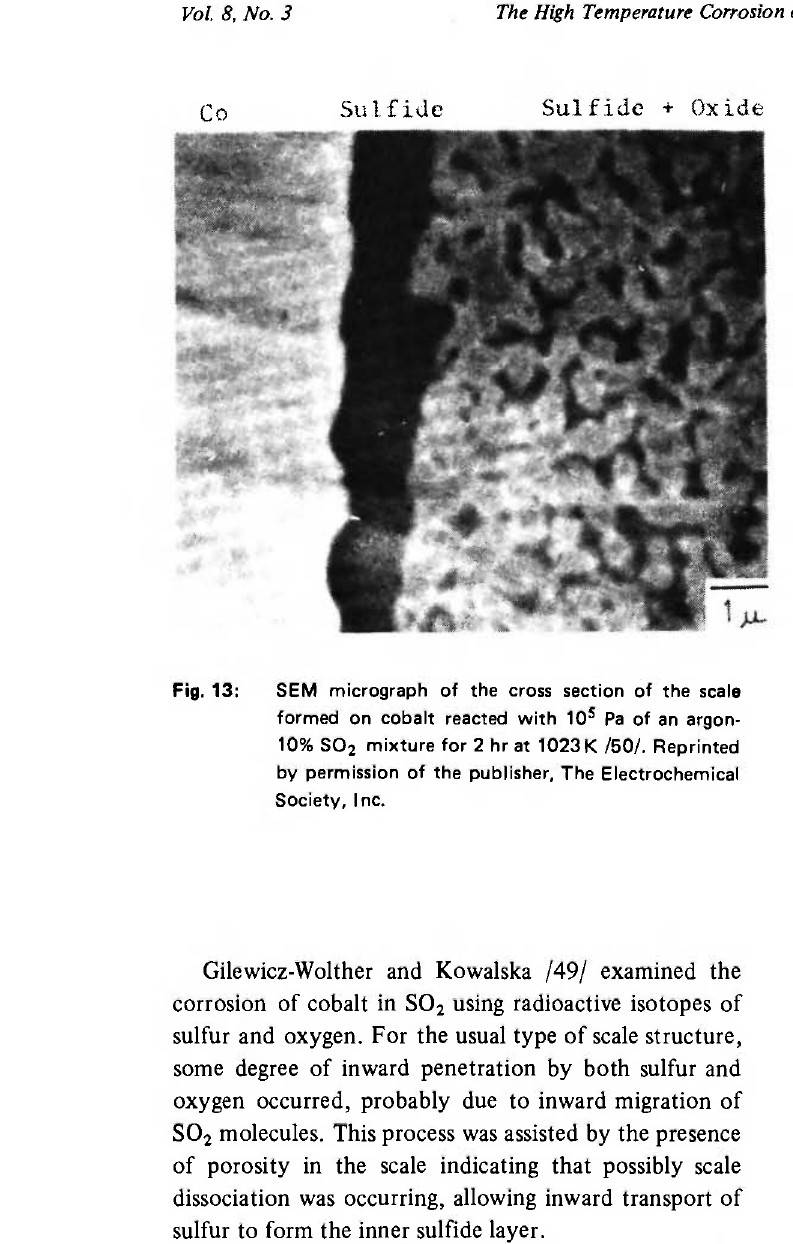
Fig. 13: SEM micrograph of the cross section of the scale formed on cobalt reacted with 10 s Pa of an argon- 10% S 0 2 mixture for 2 hr at 1023K /50/. Reprinted by permission of the publisher, The Electrochemical Society,